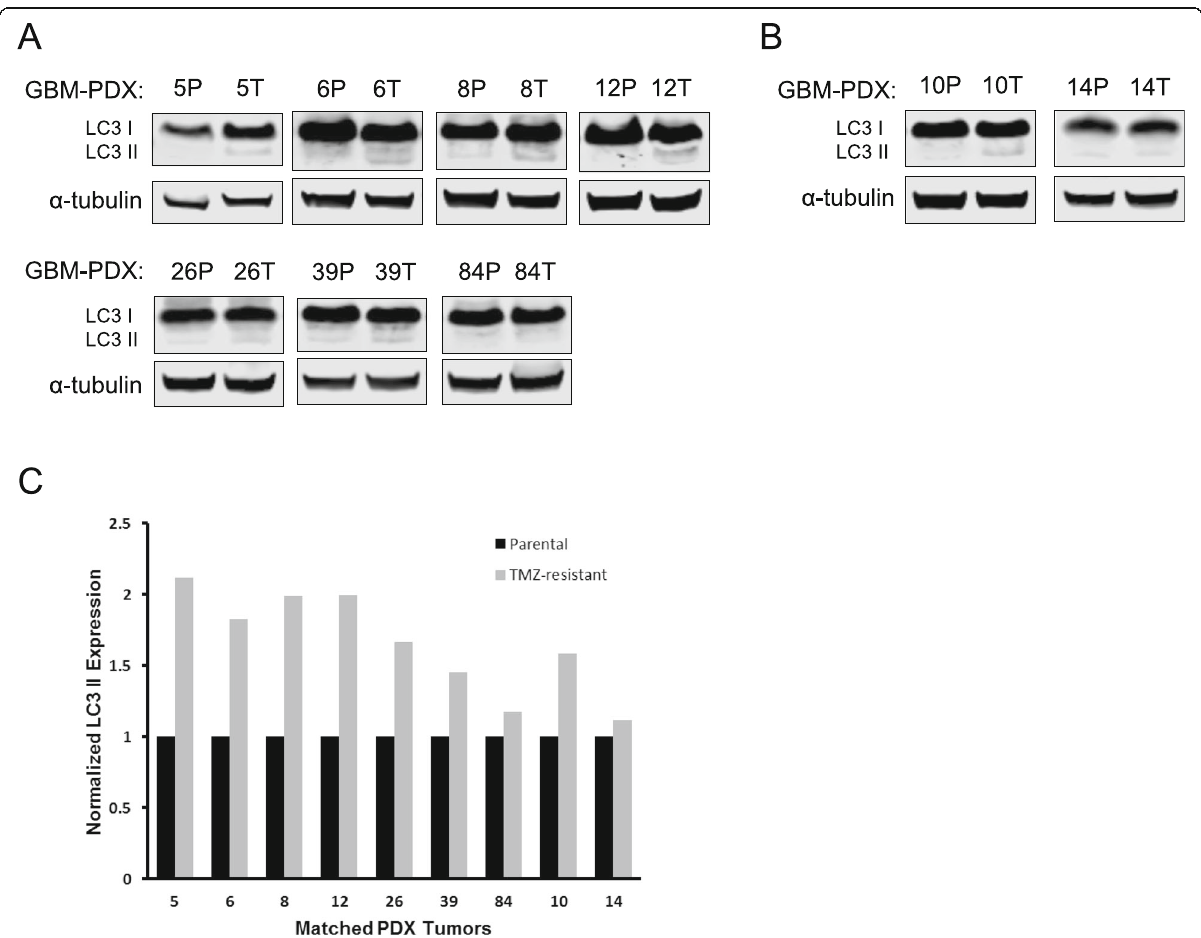
Fig. 2 TMZ-resistant GBM-PDX tumors display increased LC3 II expression. Parental TMZ-sensitive (P) and TMZ-resistant (T) GBM-PDX subcutaneous tumors that were derived from either ( a ) primary tumor resections or ( b ) recurrent tumor resections were harvested and lysed for western blot analysis. LC3 protein levels were examined by western blotting and α -tubulin was used as a loading control. c Densitometry was used to quantify the western blot